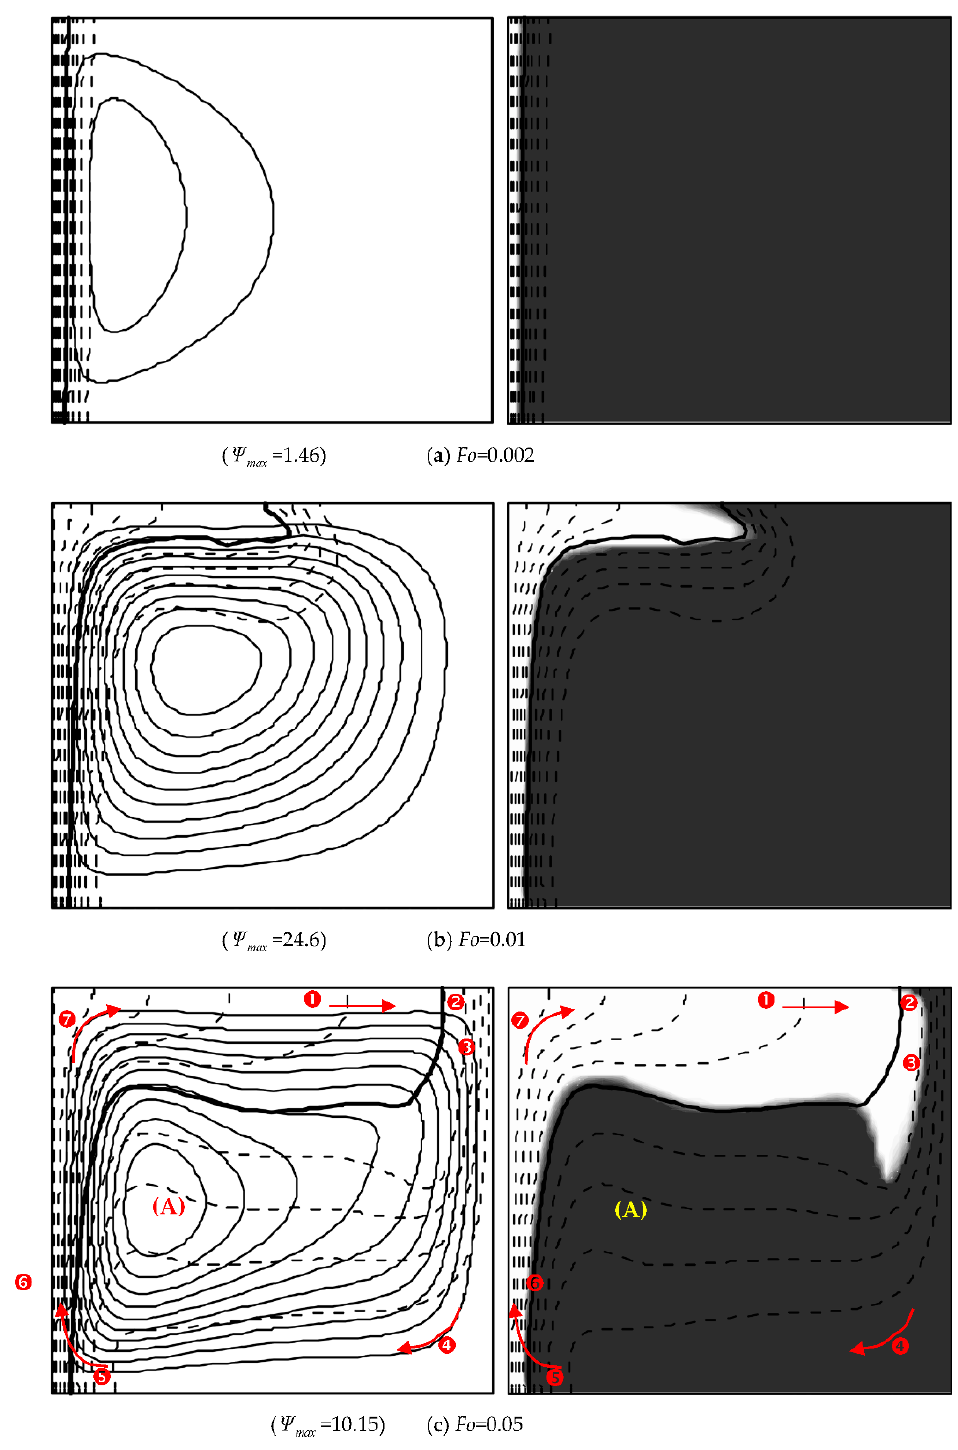
conduction, as shown in Figure 4a.